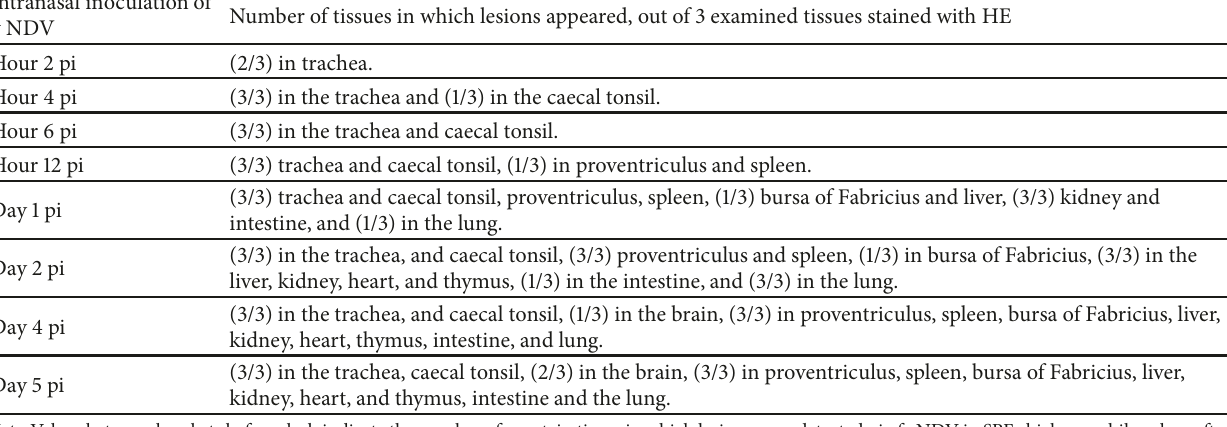
Table 4: Appearance of lesions induced by vNDV in different HE-stained tissues from hr 2 till day 6 pi. Intranasal inoculation of Number of tissues in which lesions appeared, out of 3 examined tissues stained with HE v NDV Hour 2 pi (2/3) in